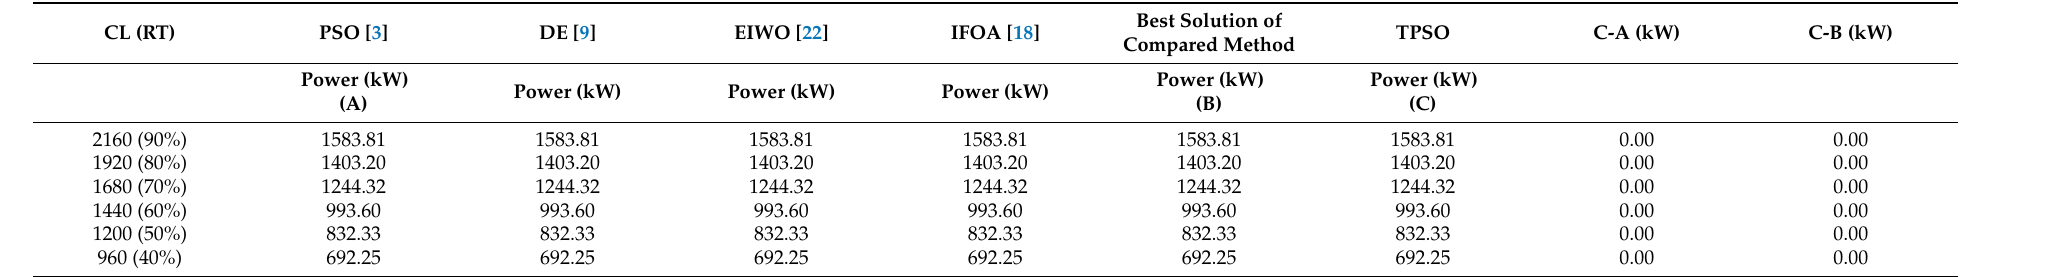
Table 15. Comparison of optimum value operated by PSO, DE, EIWO, IFOA and best known solution in Case